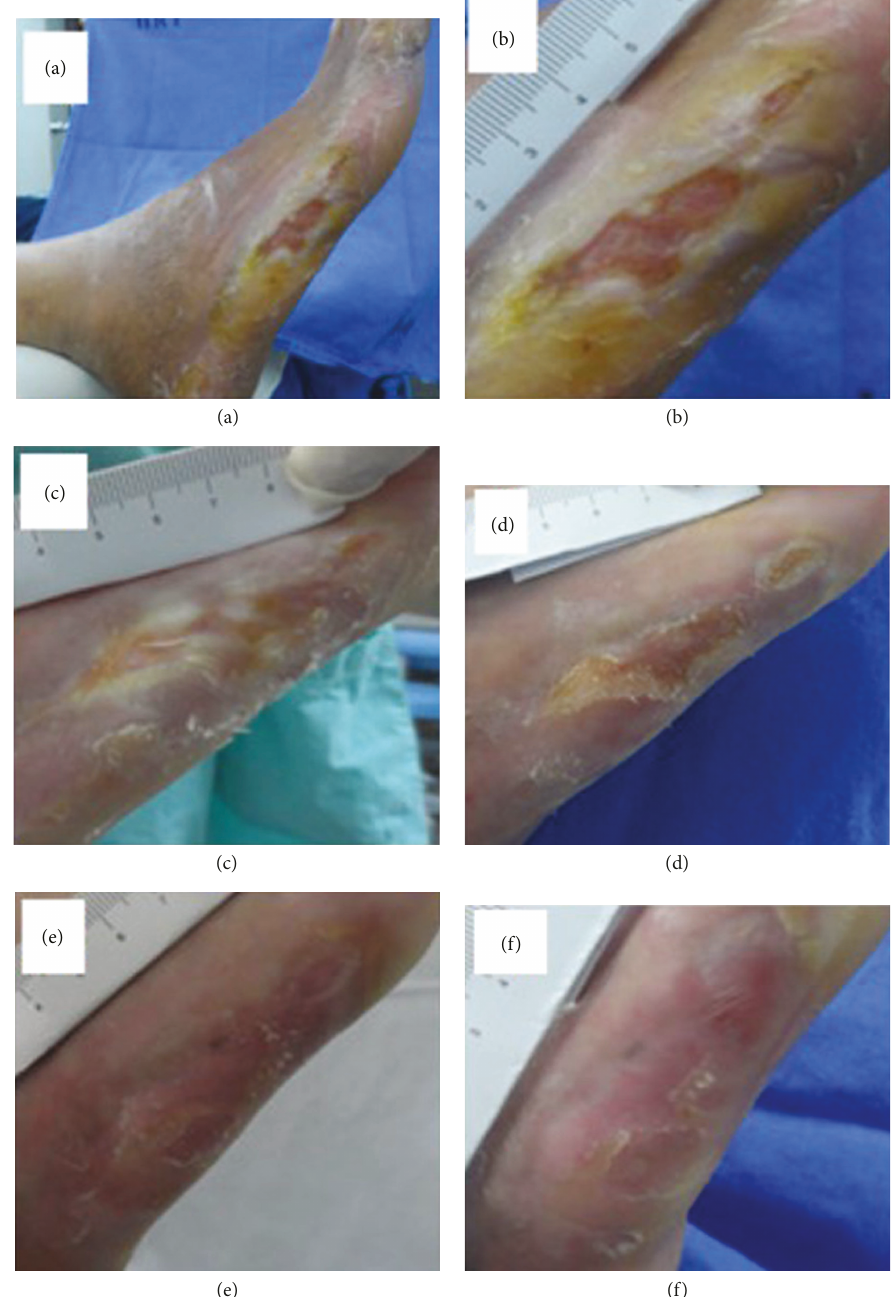
Figure 6: Photo clinical follow-up. Patient 2: experimental group: (a) ulcerated foot region; (b) early (before the tissue neoformation-inducing system); (c) posttreatment (after using the tissue neoformation-inducing system) (1 week); (d) 2 weeks; (e) 3 weeks; (f) 4 weeks. This fi gure is reproduced from Reis [42], public